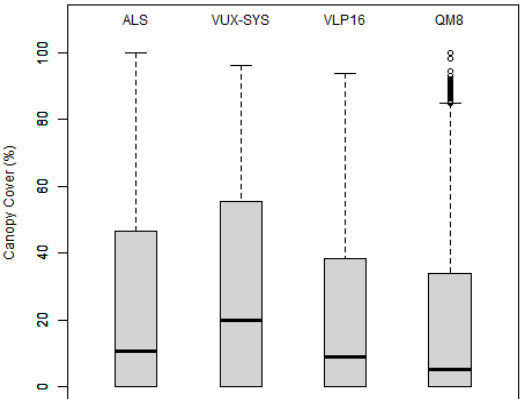
Figure 10. Boxplots of canopy cover (%) values for the 200 × 200 m study area, acquired by the different sensors. The boxplots show that the average canopy cover is much higher for VUX = SYS than for the other UAV data and the older ALS data.